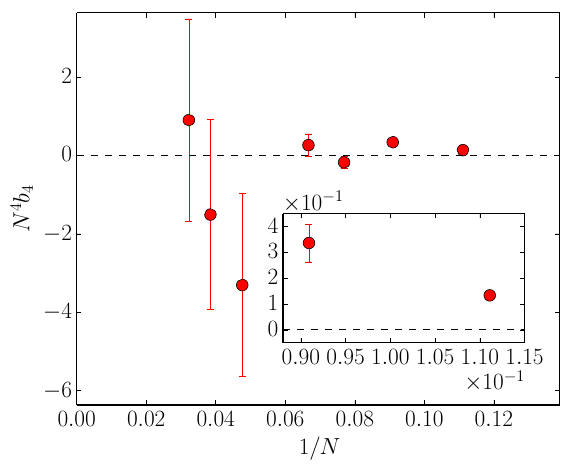
N − 1 4 coefficient in CP